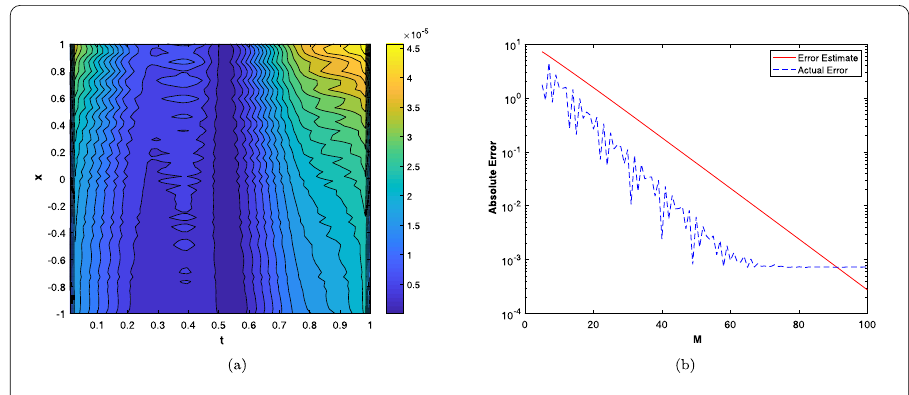
Figure 7 ( a ) The contour plot of absolute error. ( b ) The actual error vs error